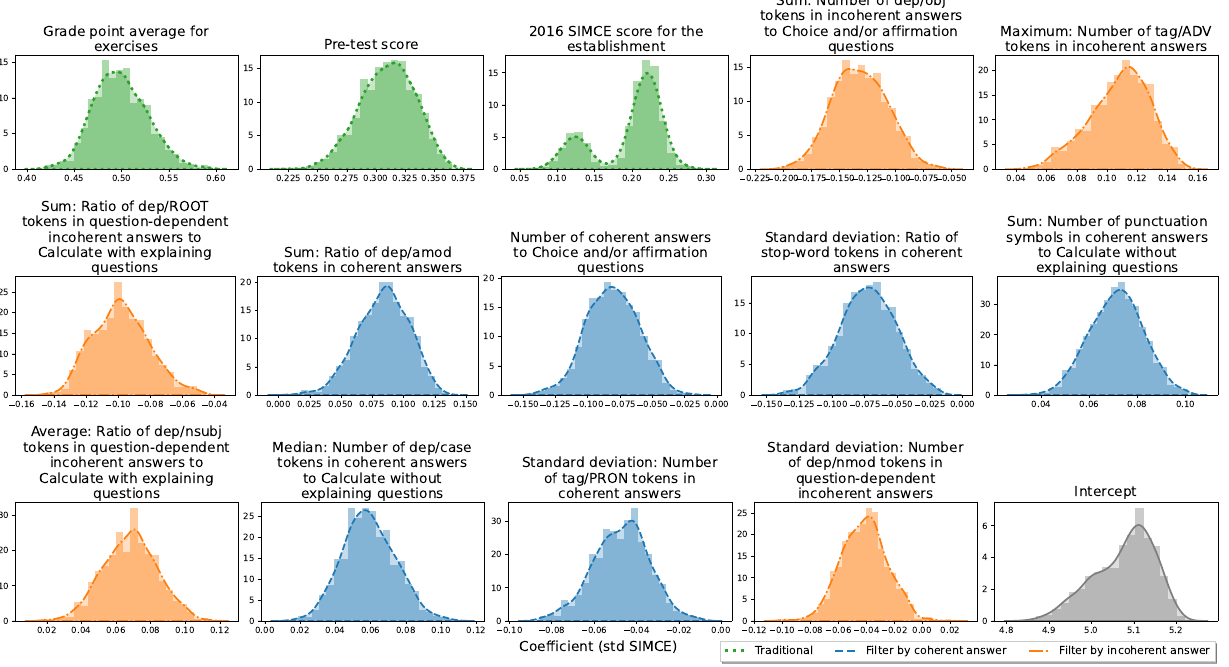
Figure 3. Distribution of each coefficient (std SIMCE) for the Open-ended model. These are obtained from 250 four-fold cross-validations. (Green) Traditional regressors. (Blue) Filter by coherent answers. (Orange) Filter by incoherent